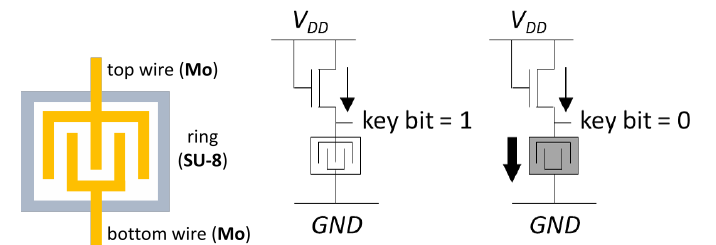
Figure 1: Interdigitated finger structure (left) and working principle of the WORM cells (middle and right) in [MSR + 14].